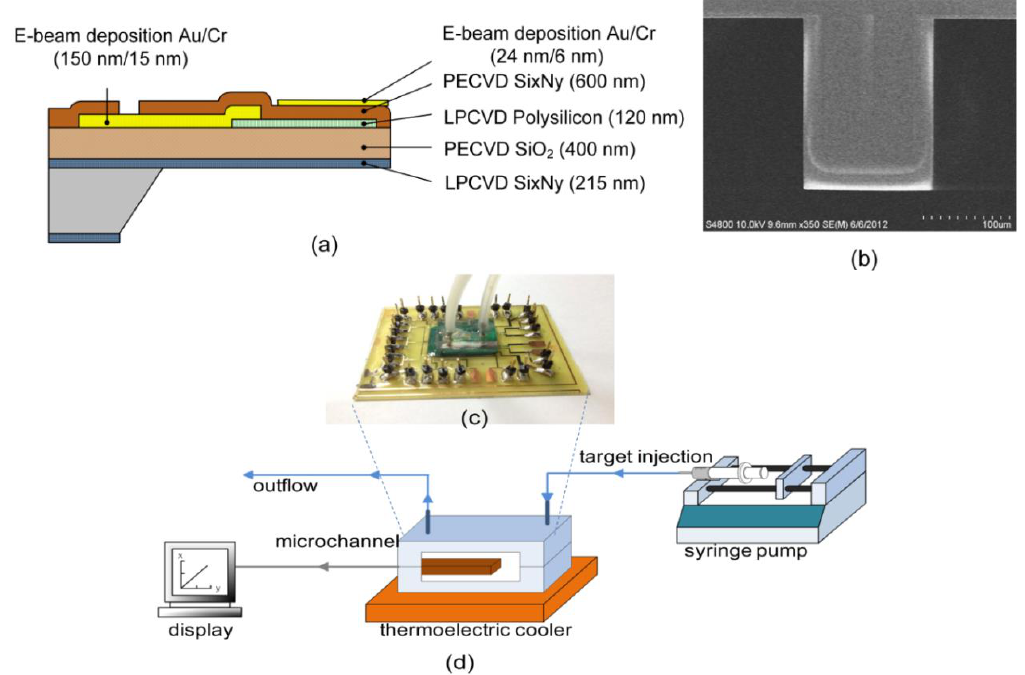
Figure 1. ( a ) Fabrication process of a piezoresistive microcantilever sensor; ( b ) an SEM image of a complete piezoresistive microcantilever biosensor; ( c ) a photograph of a packaged device; ( d ) an experimental system setup. PECVD, plasma-enhanced